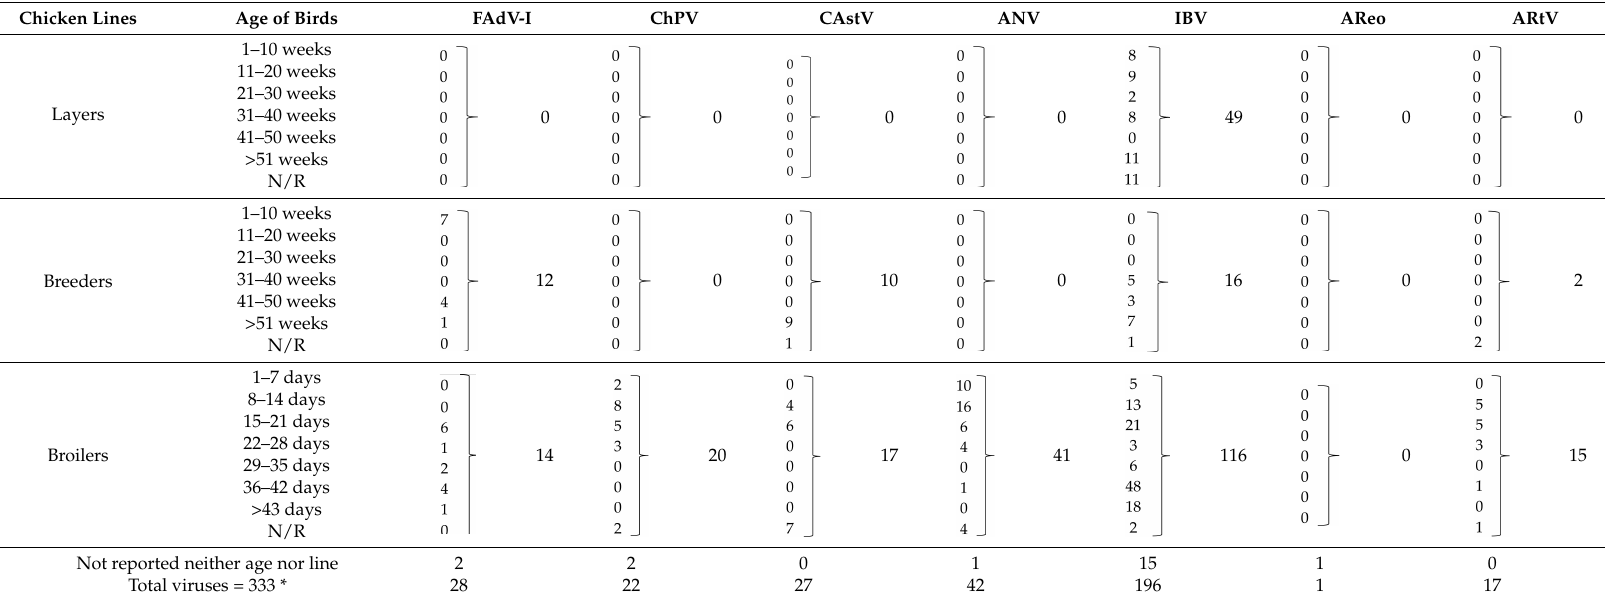
Table 8. Frequency of viruses affecting birds according to the age of